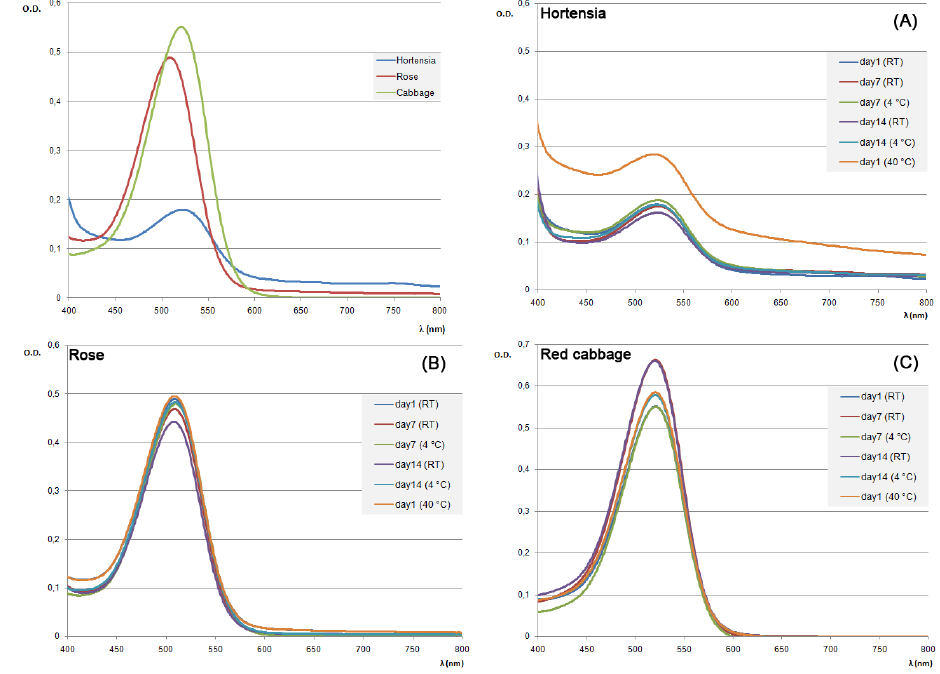
Figure 4. Optical spectra of different sensing materials in different conditions. The wavelength at which the anthocyanin chromophore shows the maximum absorbance in the pH 1.0 solution is 520 nm. The optical stability of sensing material (hortensia panel ( A ), rose panel ( B ), cabbage panel ( C )) has been monitored for a period of 14 days at different temperatures (room temperature (RT), 4 °C and 40